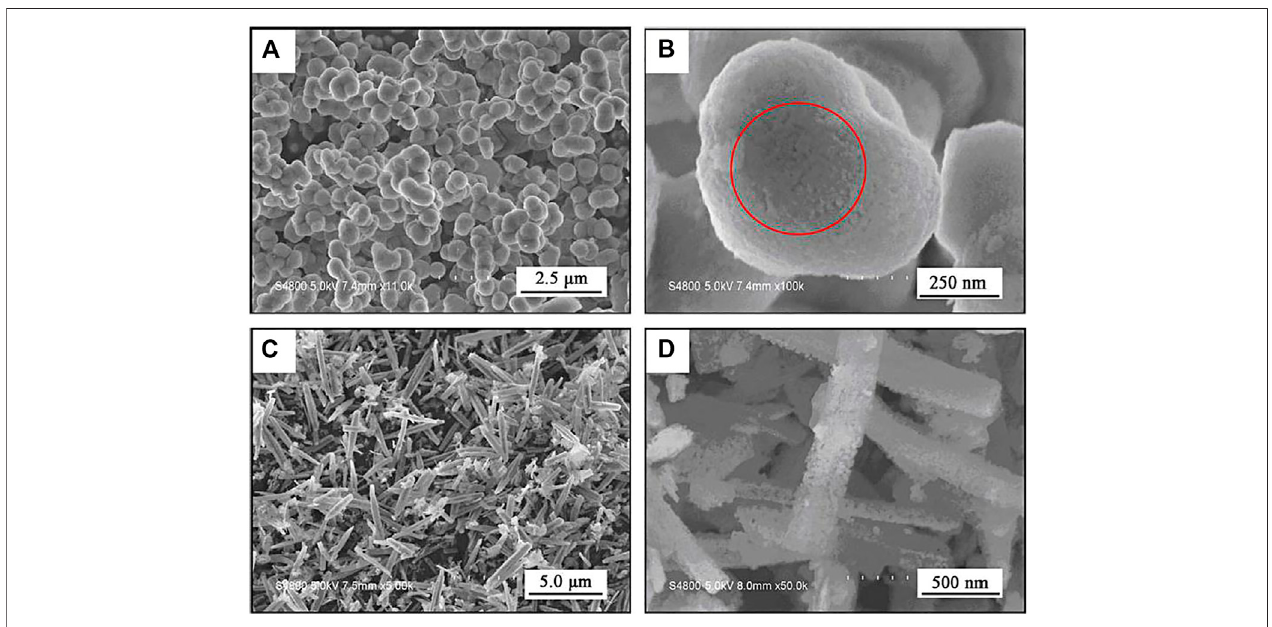
(cid:129) (cid:129) 6H 2 O,Al(NO 3 ) 3 9H 2 OandCO(NH 2 ) 2 . (A,B) 1:2:10,and (C,D) 1:2: